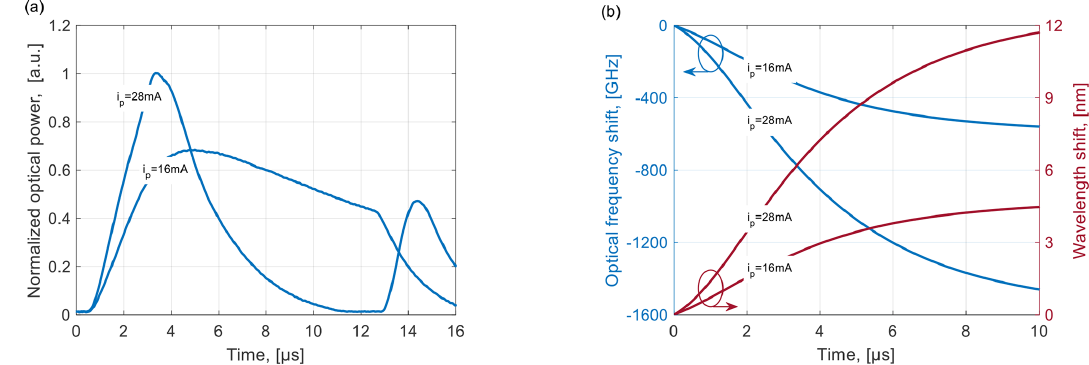
Figure 4. Optical waveforms (a) for VL-1544 captured by photodetector PD3 and corresponding (b) instantaneous optical frequency and wavelength shift achieved with a pump current of i B = 1, i P = 16 and i P = 28mA by the pulse width of 12µs and the repetition rate of 50Hz.